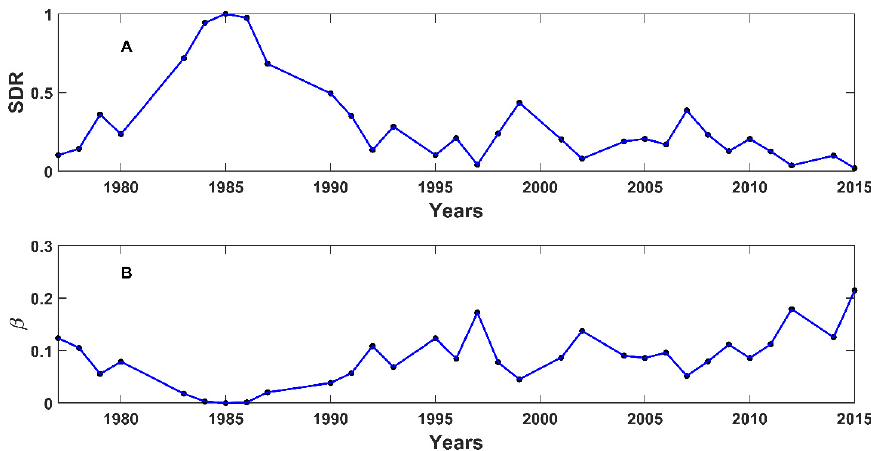
Figure 10. Annual sediment delivery coefficient, upper panel ( A ), and estimated values of the β parameter for the 1977 to 2015 period, lower panel ( B ).